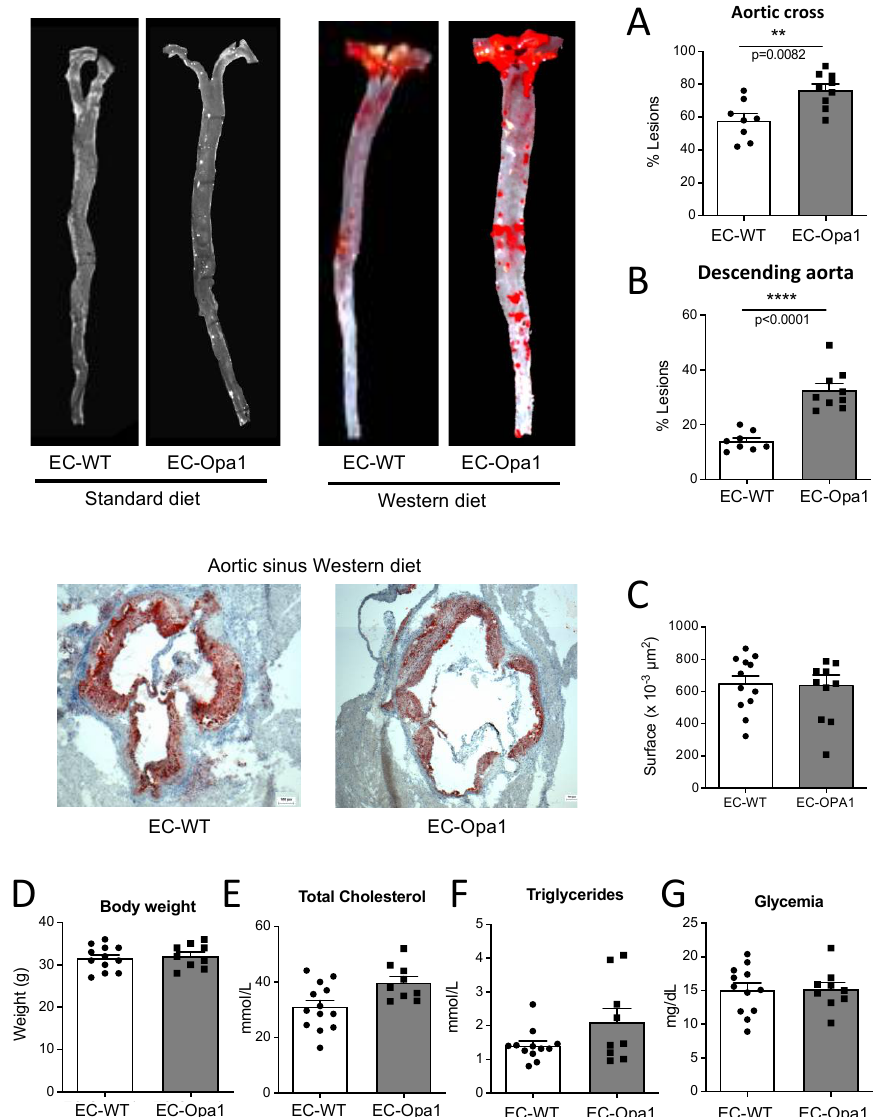
Figure 9. Consequence of Opa1 deficiency in endothelial cells on plaque formation. EC-Opa1 and EC-WT male mice that were three months old were fed with an atherogenic diet (Western diet) and compared EC-Opa1 and EC-WT mice fed with a standard diet. After 4 months the aorta was collected from the sinus to the iliac bifurcation and stained with Oil red-O. Lipid deposition was quantified in the aortic cross, ( A ), in the descending aorta ( B ) and in the aortic sinus ( C ). Bodyweight ( D ), plasma cholesterol ( E ), triglycerides ( F ), and glycemia ( G ) were measured in each group of mice. Means ± SEM are shown (9 EC-Opa1 and 8 EC-WT mice per group were used). ** p = 0.0082 ( A ); **** p < 0.0001 ( B ) and NS ( B – G ), Two-tailed Mann–Whitney test.